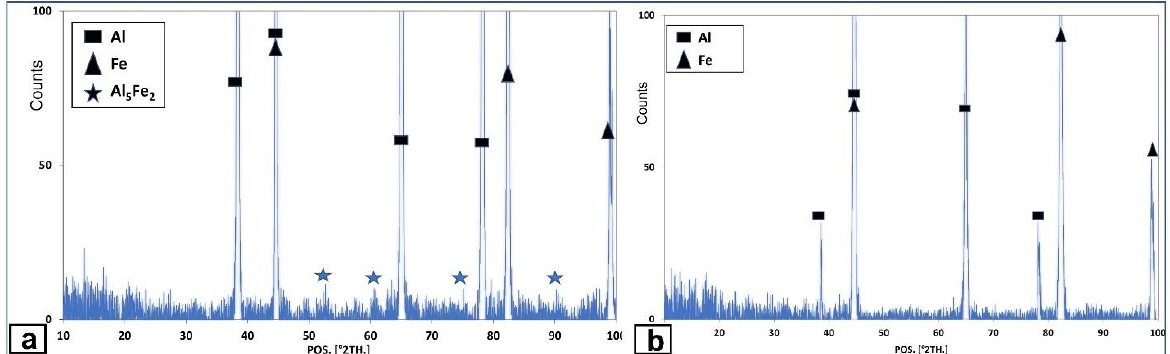
Figure 7. XRD analysis of the aluminum/steel interface produced with FSP tool pin length of 3 mm and rotation speed of ( a ) 1500 rpm and ( b ) 1000 rpm.